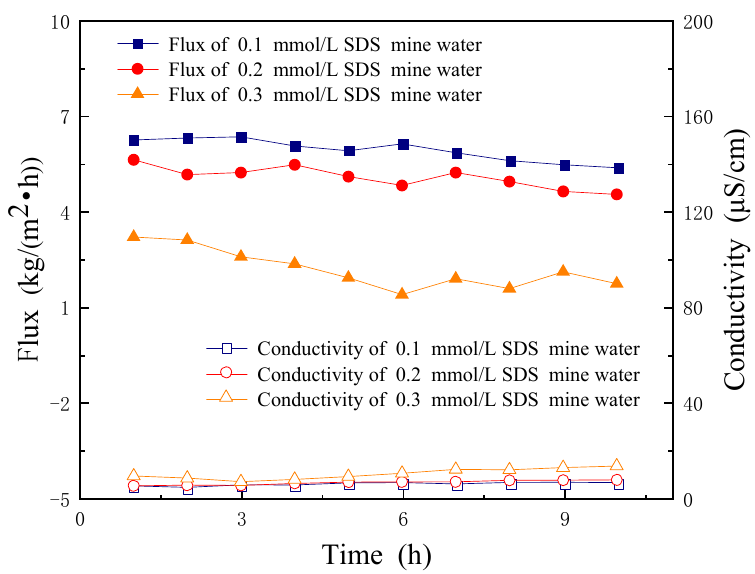
Figure 12. Flux and conductivity variation of PVDF-O membrane in the treatment of mine water containing 0.1, 0.2 and 0.3 mmol/L SDS by DCMD.